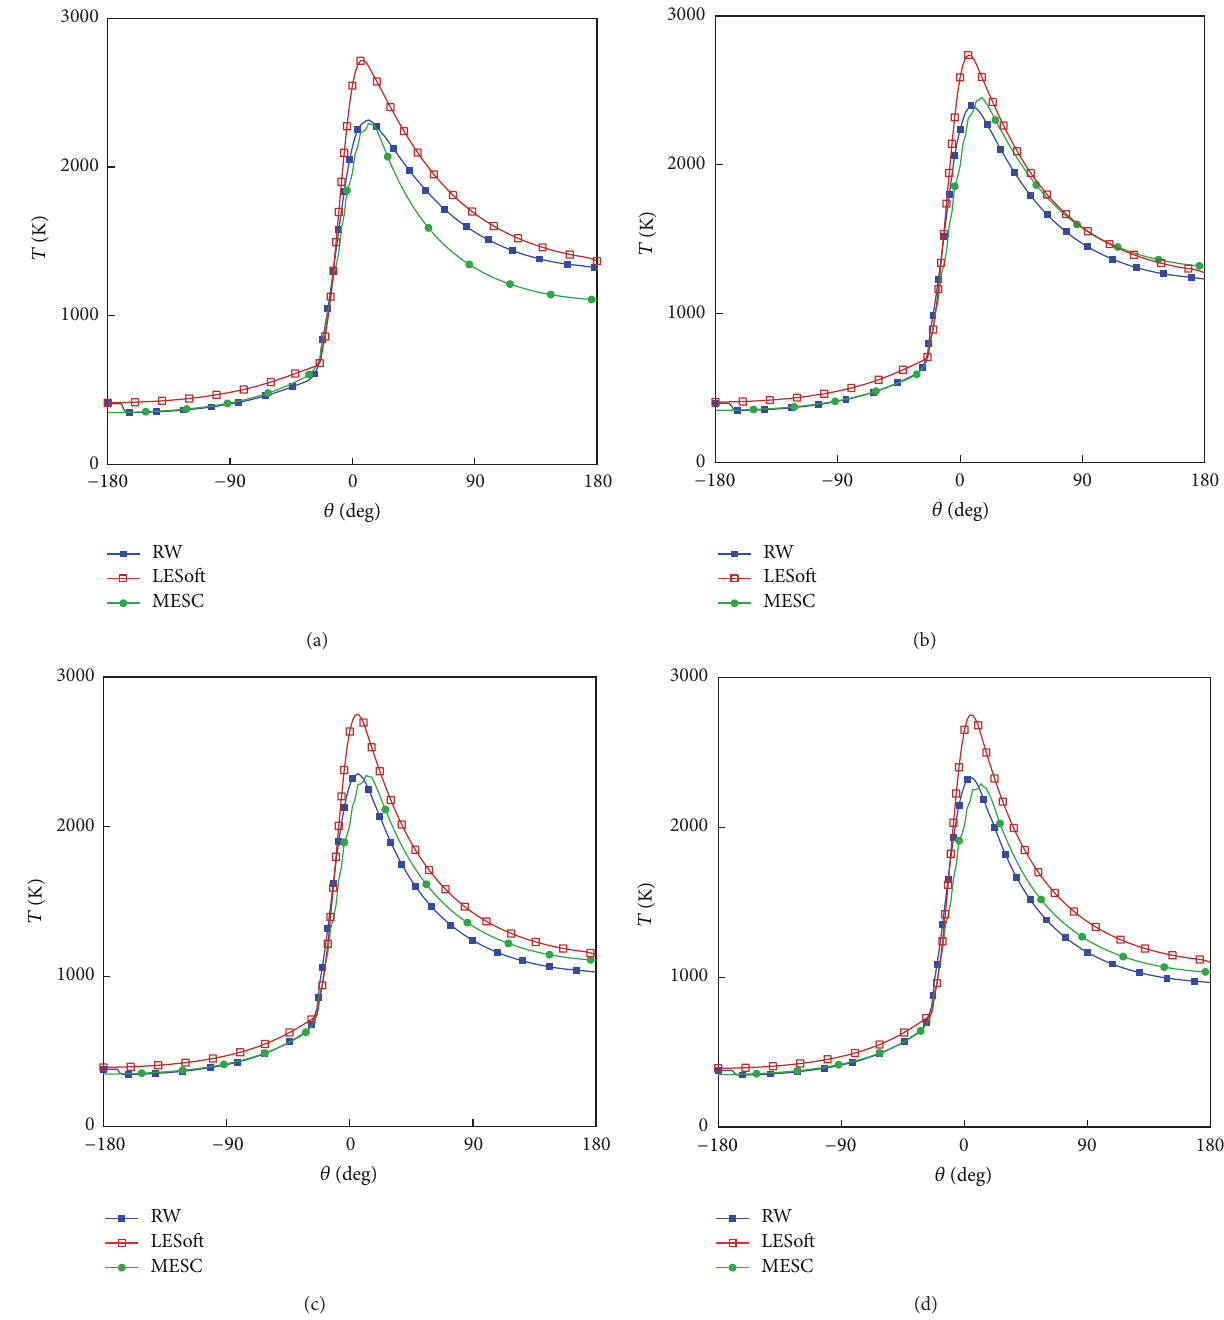
Figure 16: Profiles of temperature for compression ratios of 6 (a), 8 (b), 12 (c), and 14 (d).